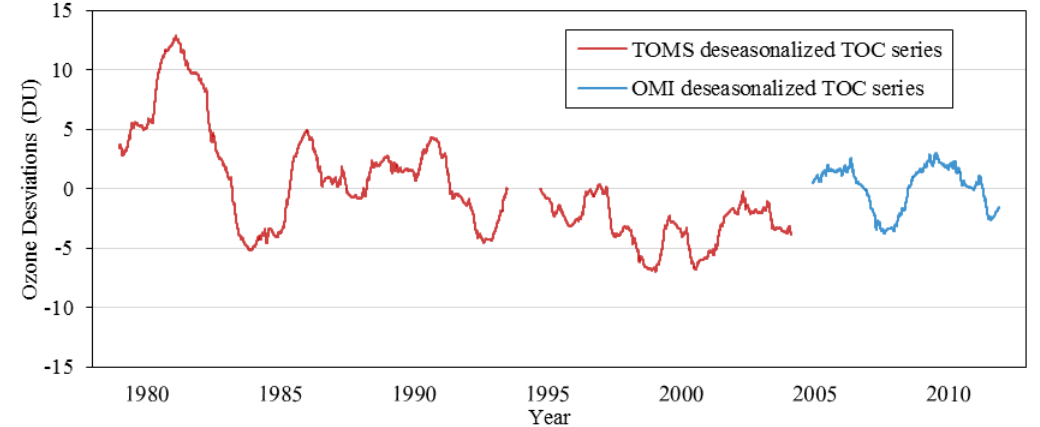
Figure 5. Time series and the trend after removing seasonal cycle and the QBO over the Yangtze River Delta (31.5°N) for the period 1978–2013.